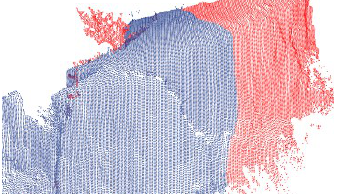
Figure 2. Incorrect surface generated by ordinary vegetation removal method. The left part of red points representing real vegetation points was removed correctly, while the right part representing land surface was removed wrongly.